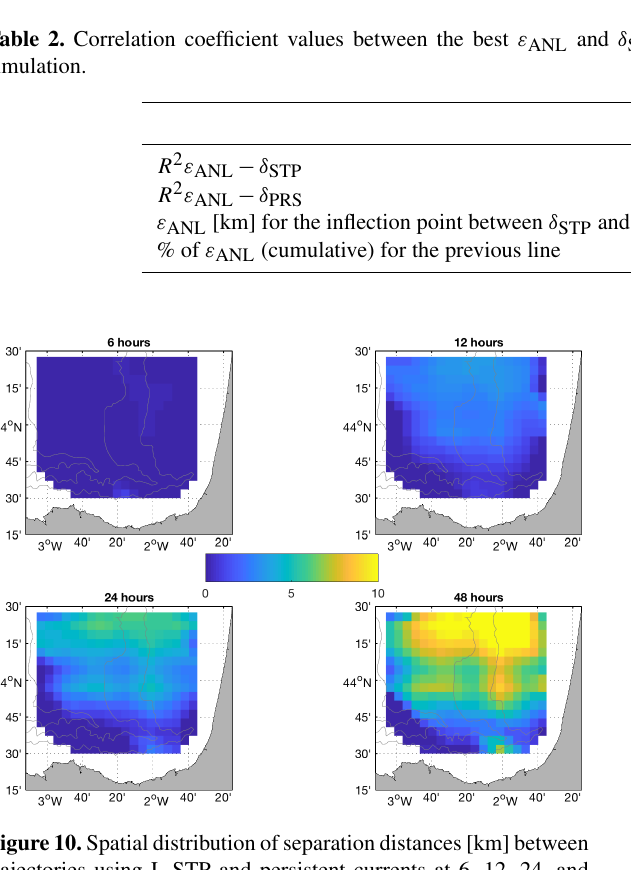
Figure 10. Spatial distribution of separation distances [km] between trajectories using L-STP and persistent currents at 6, 12, 24, and 48h for the BoB HFR system.